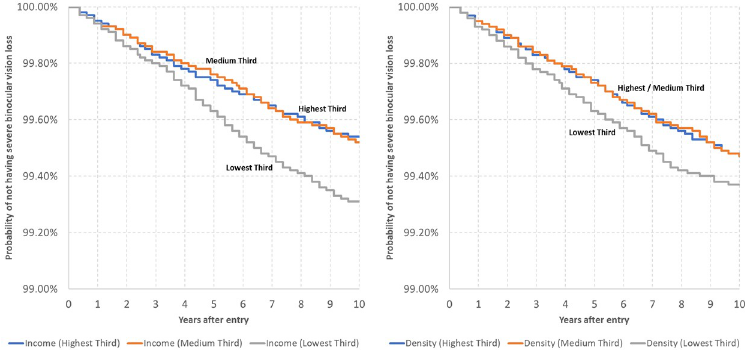
Fig 3. Kaplan-Meier survival functions by type of living region, 2006-2015, AOK data (abbreviated y-axis).